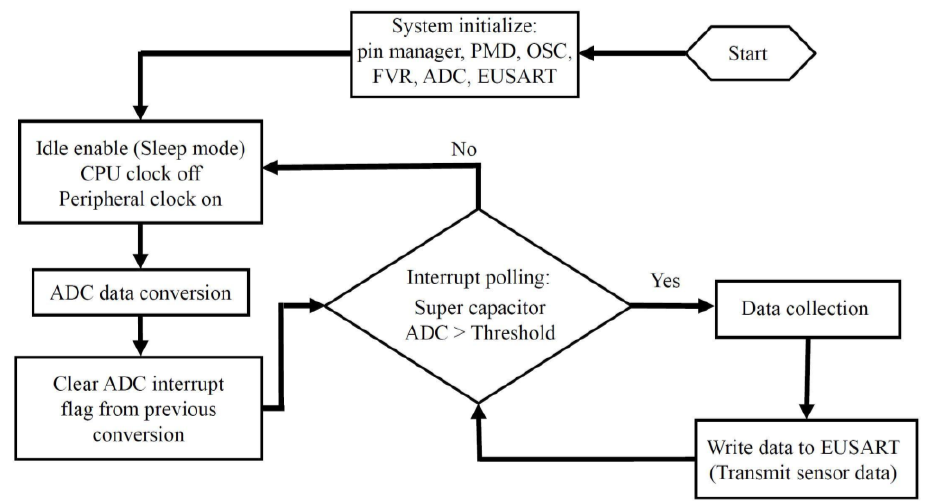
Figure 10. A signal acquisition process flowchart of the wireless vibration sensor presented in this work showing detailed description of the program starting at the initialization process of the micro- controller and ending at the transmission of